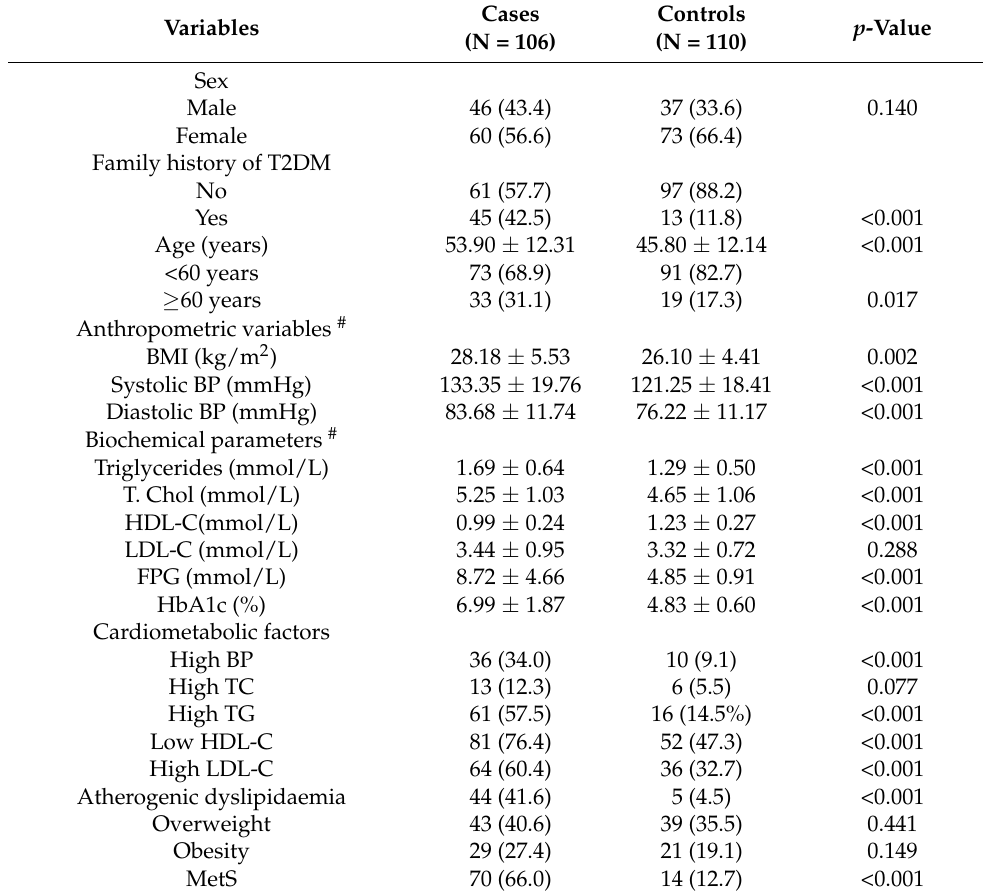
Table 1. Comparison of demographic variables, anthropometric measures and biochemical profiles between the cases and